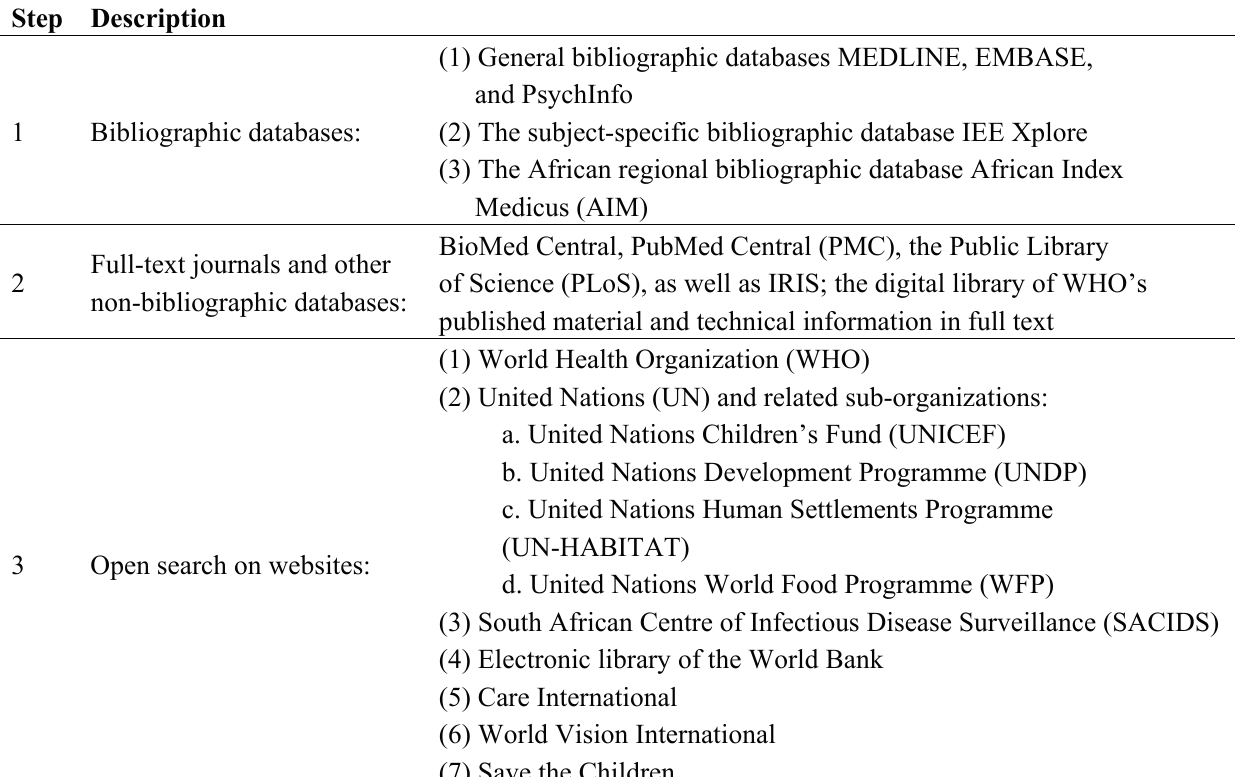
Table 2. Systematic literature and information search